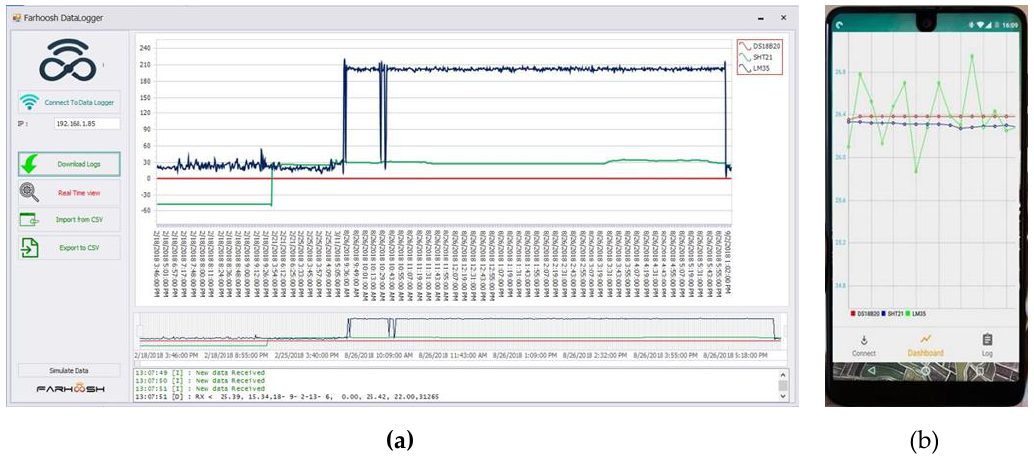
Figure 3. User interface (( a ) data logger; ( b ) mobile